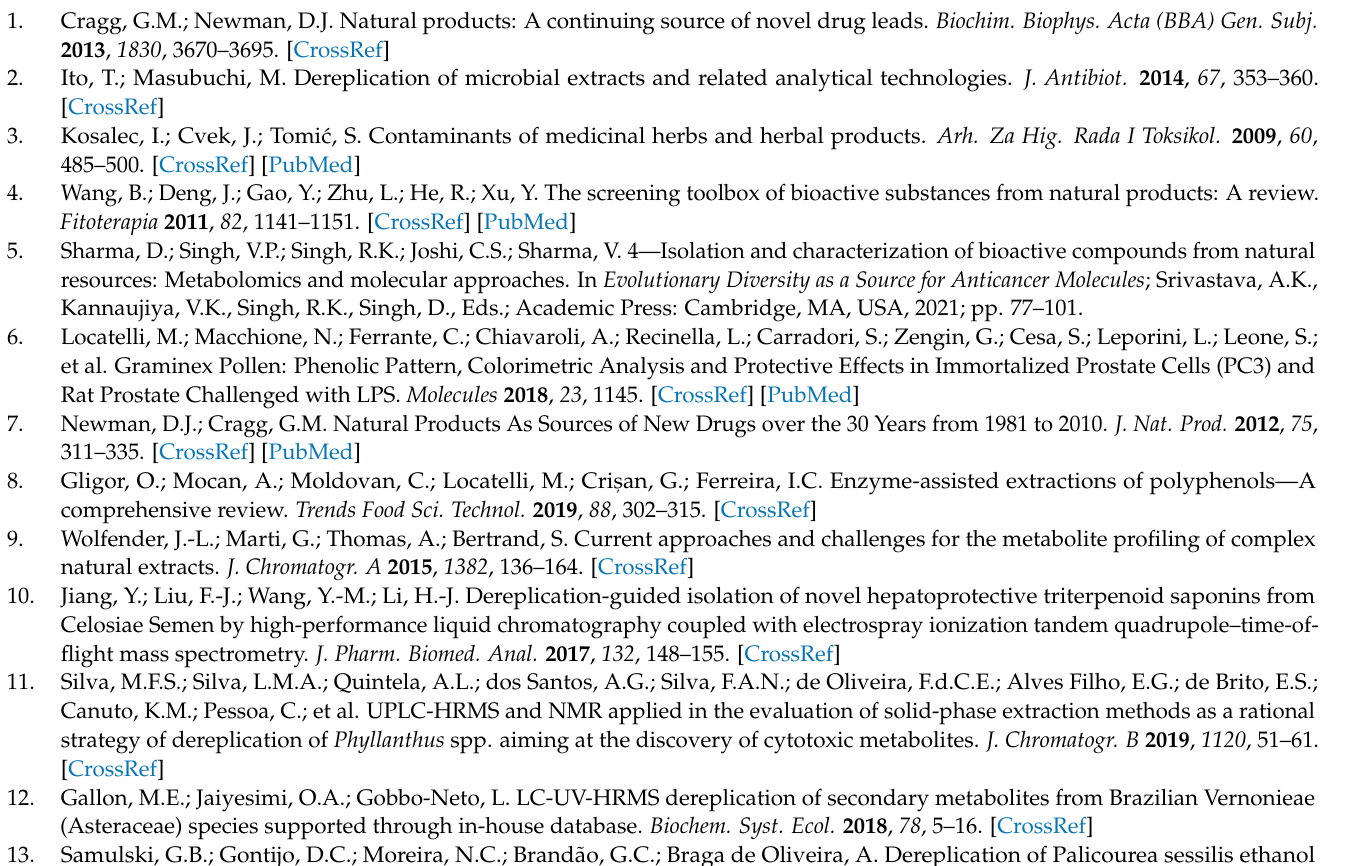
Table S3: Retention times of standards using three different columns, Table S4: %Accuracy and %RSD of compounds; Table S5: Data of compounds detected in Pool-1 (positive and negative ionization